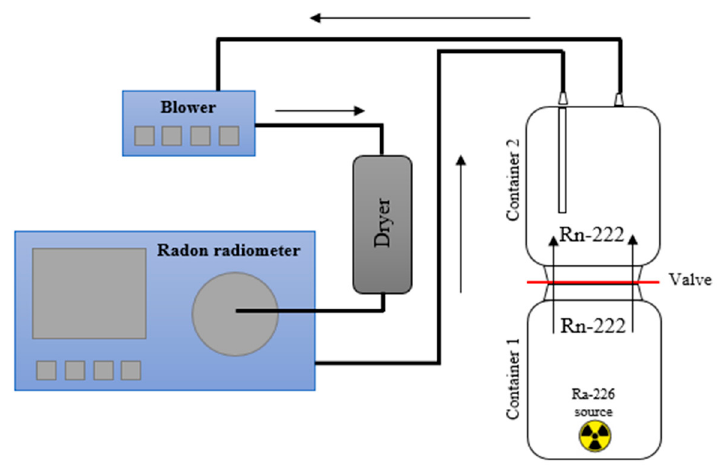
Figure 2. Experimental facility for assessing radon leakage.